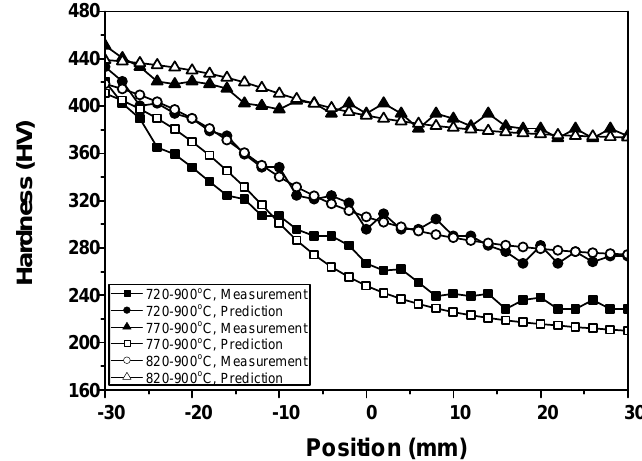
Figure 16. Comparison of the hardness between the measurement and prediction for the transition zone.